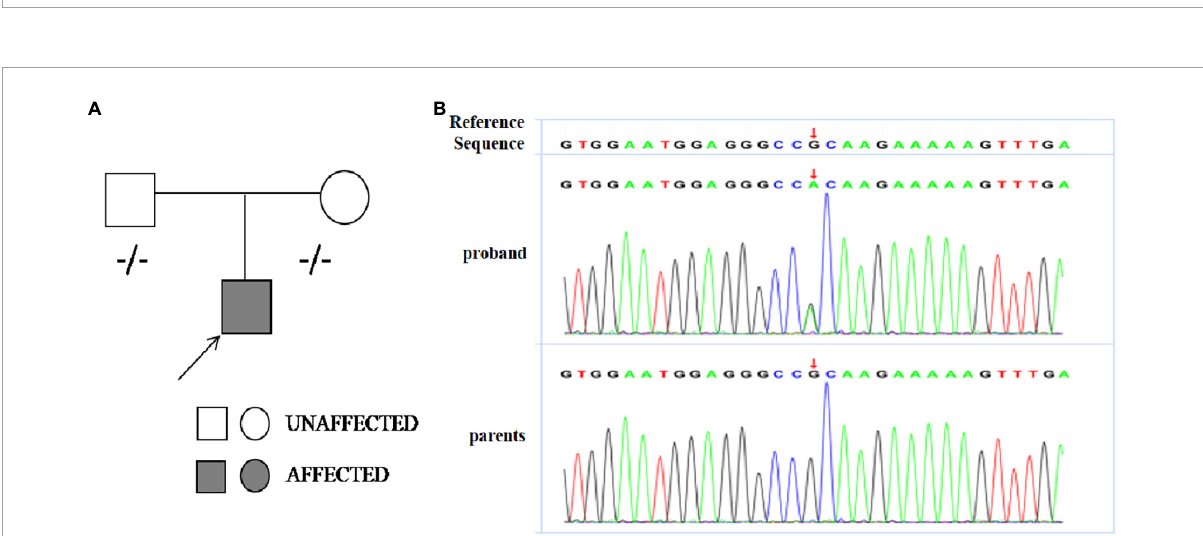
FIGURE3 (A) Pedigree analysis of the family of patient. The arrow points out the proband. Circles correspond to female. Squares correspond to male. The mutation was indicated –/– if negative. (B) Sanger sequencing revealed a heterozygous missense mutation [c.611(exon8)G > A,p.R204H] of TNNI3 in the proband boy and his parents did not carry the